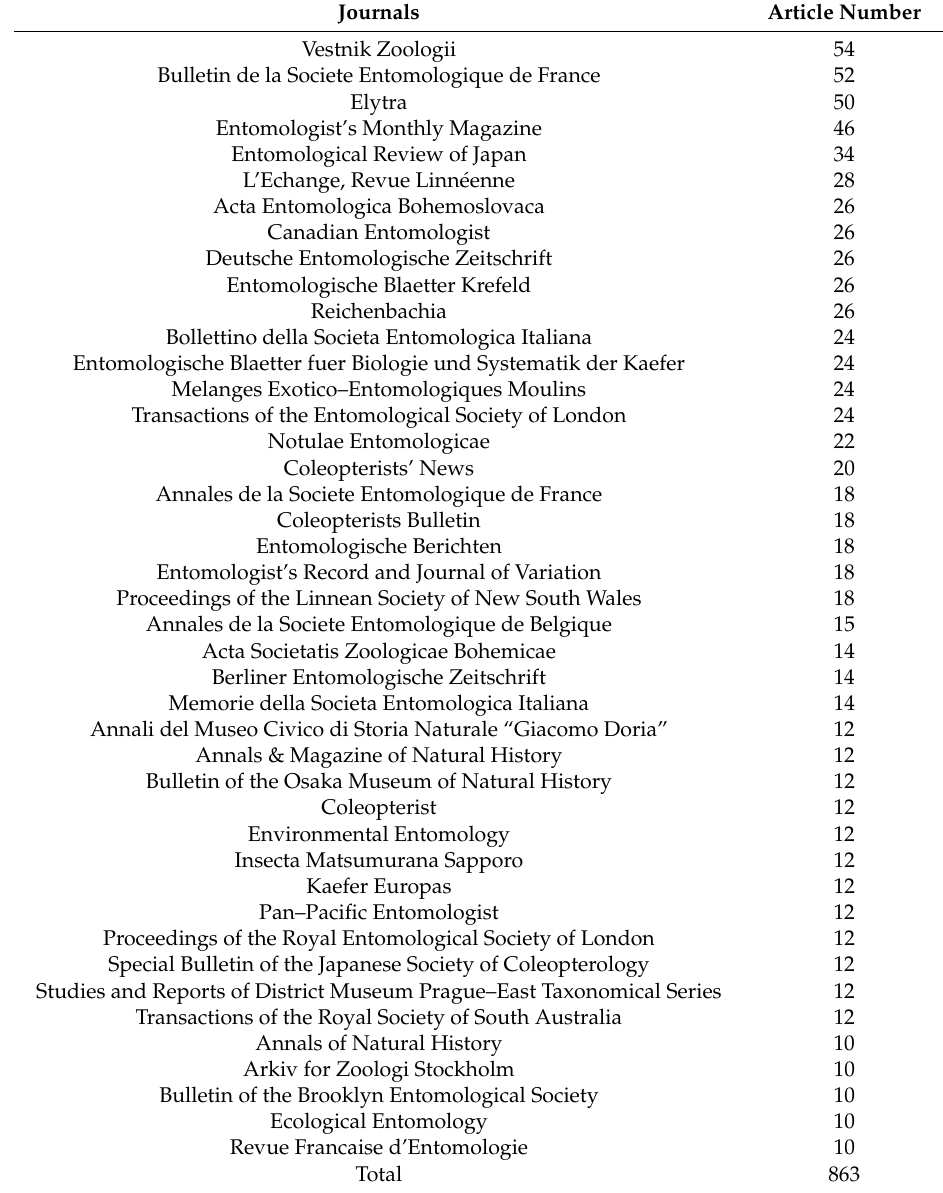
Table 1. The distribution of articles by